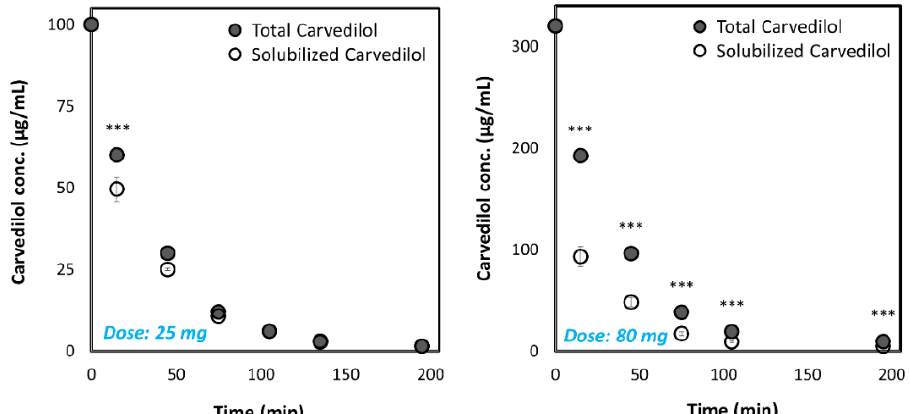
Figure 1. Dissolution of the highest carvedilol dose for IR and CR drug products on the market (25 mg and 80 mg, respectively) in the dynamic GIT environment, using the pH-dilution dissolution method. Values are presented as means ± SD; *** p < 0.001; n = 5. The pH at each time point for IR: 1.4 at 15 min; 1.9 at 45 min; 5.8 at 75 min; 6.9 at 105 min; 7.2 at 135 min; 7.3 at 195 min; and for CR drug product: 1.6 at 15 min; 2.9 at 45 min; 7.0 at 75 min; 7.4 at 105 min; 7.6 at 195 min.